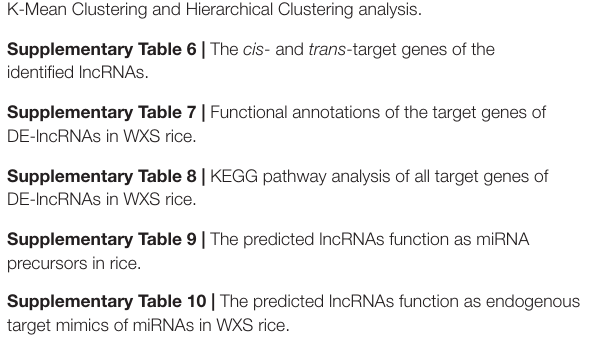
Supplementary Table 4 | Statistics of significantly differentially expressed lncRNAs and mRNAs.